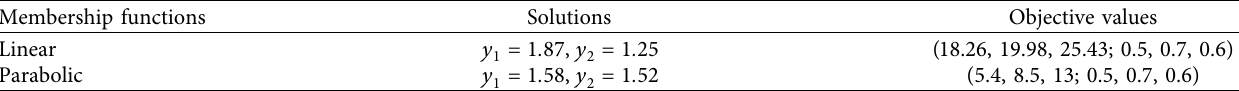
Table 2: Result discussion of Example 2.